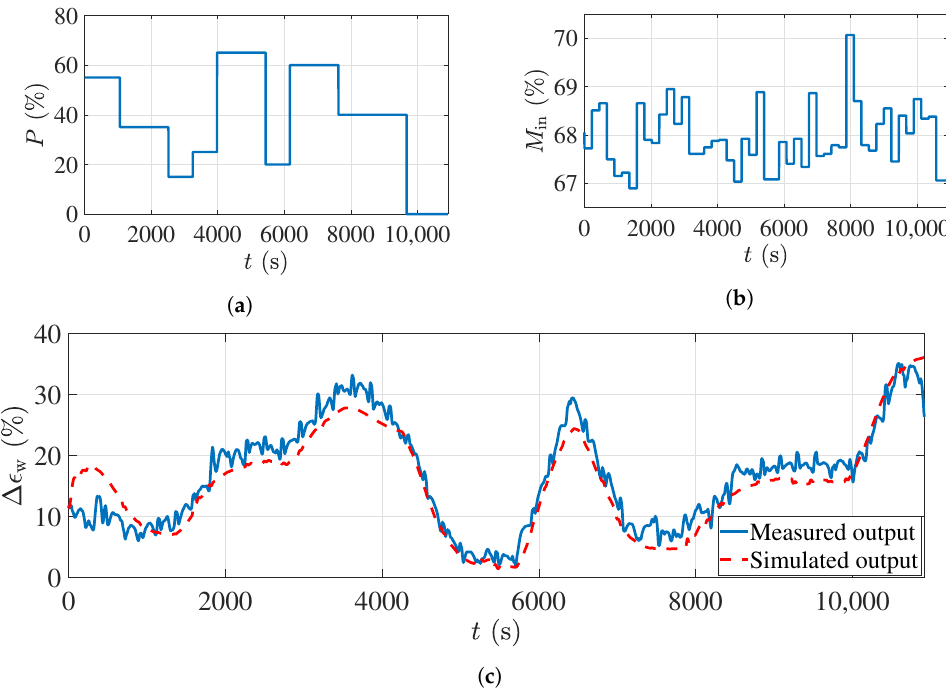
Figure 9. The input–output dataset with the APRBS input signal used for validation of the process model: ( a ) The applied input power percentage to the microwave sources. ( b ) The input foam moisture variations. ( c ) Comparison between the actual measurements and the model output.